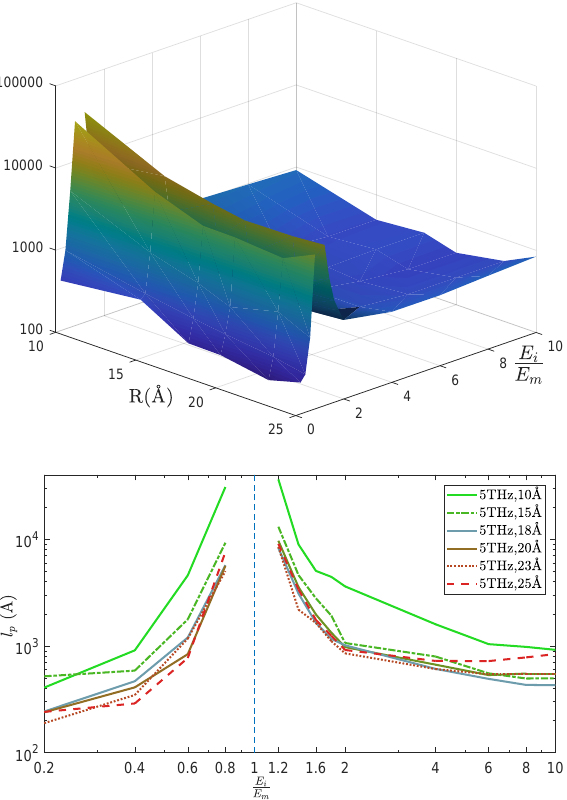
Figure 11. Penetration length l p ( E i frequency of wave packets ω = 5 THz.(Top: 3D Bottom: